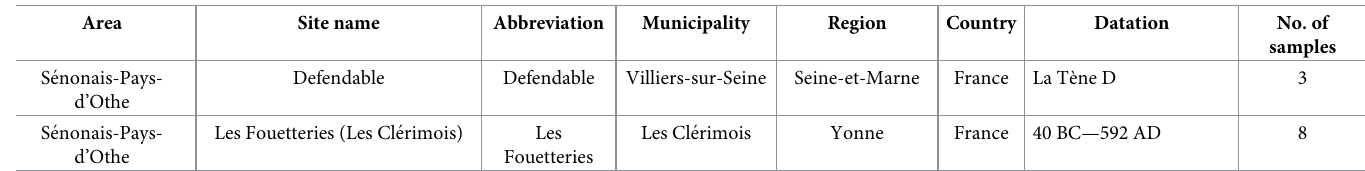
PLOS ONE | https://doi.org/10.1371/journal.pone.0268209 May 17,